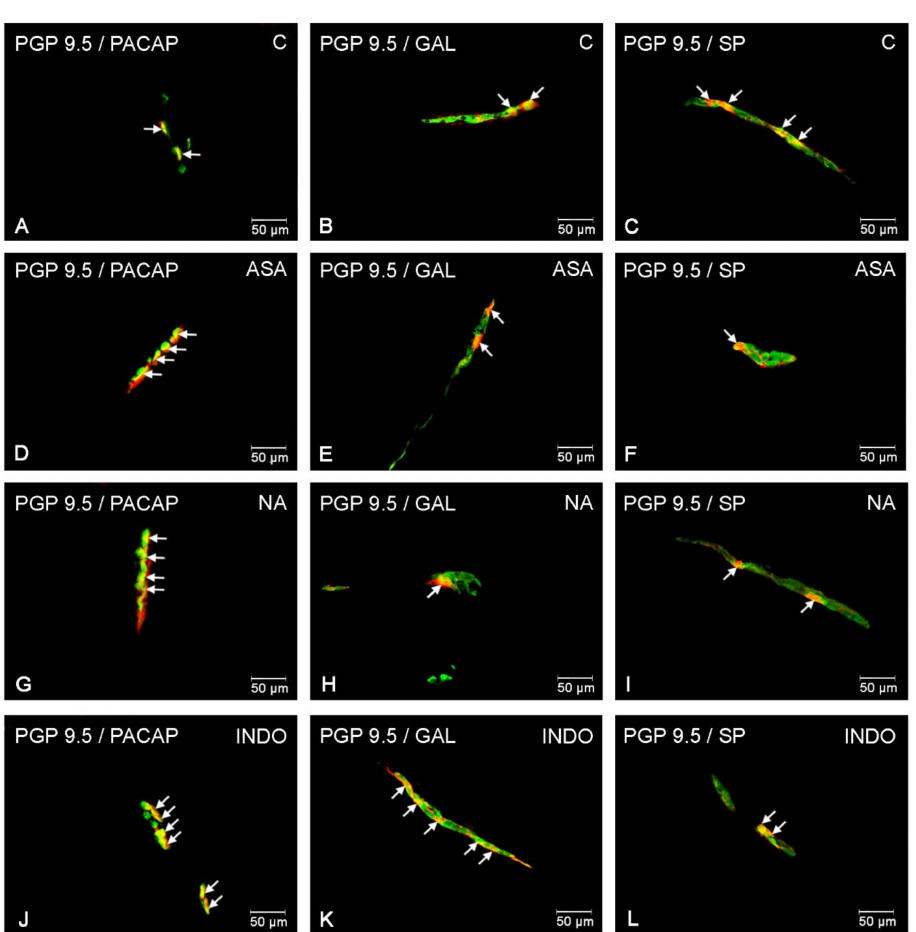
Figure 5. Inner submucosal neurons of porcine jejunum containing the protein gene-product 9.5 (PGP 9.5) (used as a pan neuronal marker) and PACAP, GAL and SP in physiological conditions ( A – C ) and following aspirin ( D – F ), naproxen ( G – I ), indomethacin ( J – L ) treatment. The photographs were created by digital superimposition of two color channels (green for PGP 9.5 and red for selected neurotransmitter). The arrows in the photos point to co-localization of both antigens in the studied